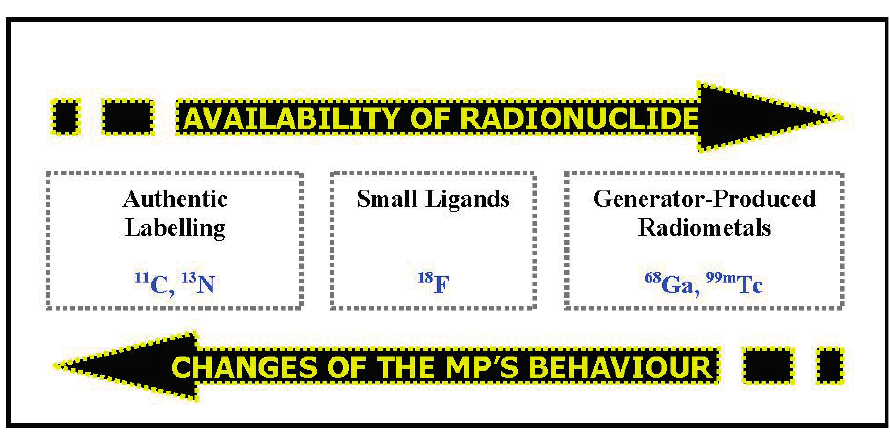
Figure 3. The radiochemist’s dilemma: availability of radionuclides vs. potential changes of in vivo behaviour. Usually, the better the availability of the radionuclide (e.g., Tc-99m > F-18 > C-11) the more pronounced the observed changes of the MP’s properties regarding e.g., uptake, binding characteristics and